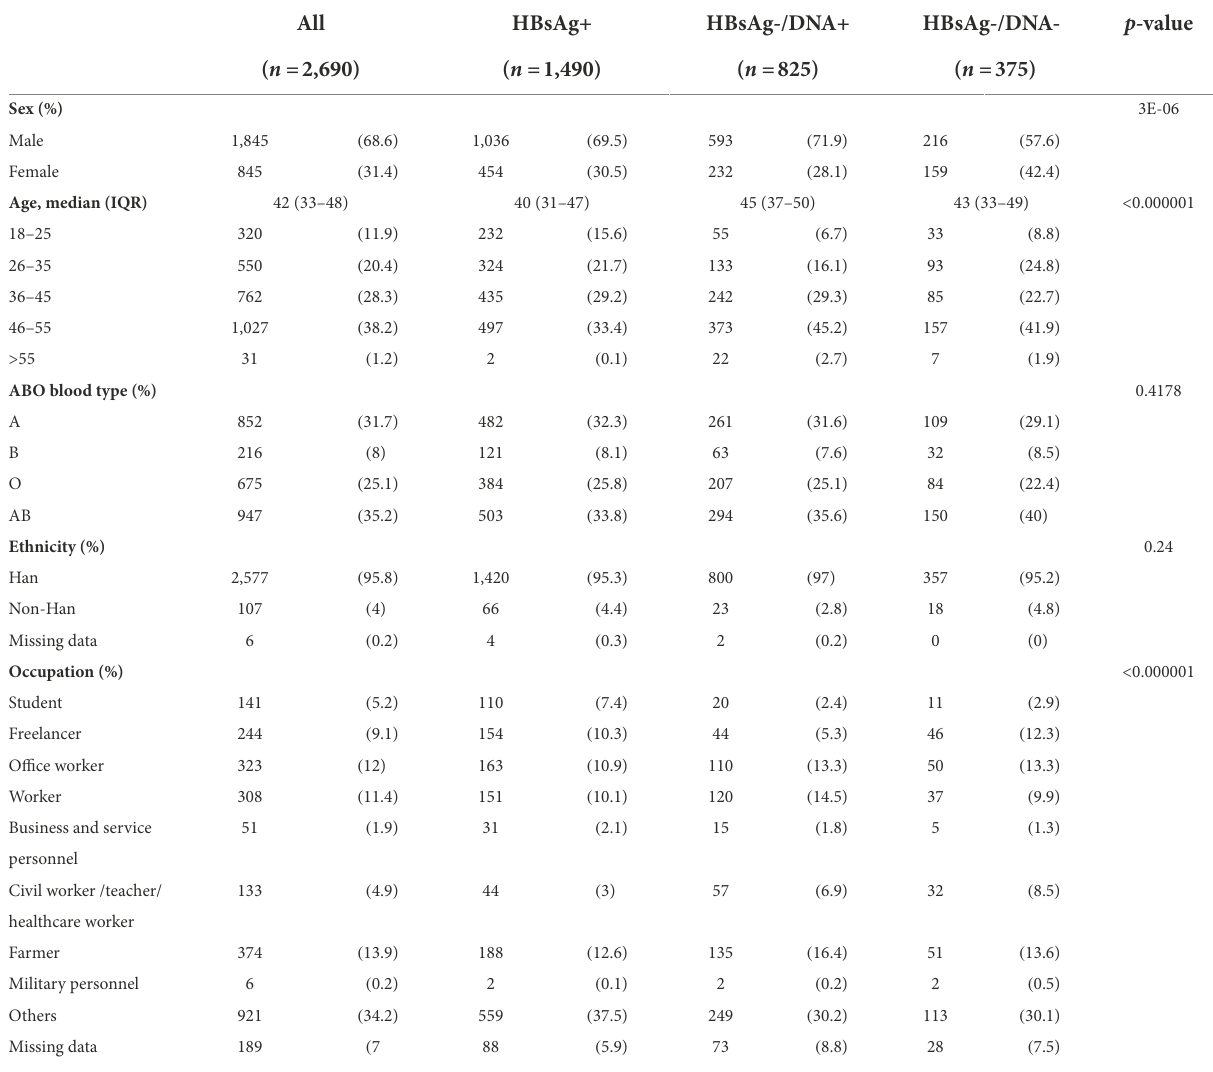
TABLE 1 Characteristics of enrolled donors ( n =